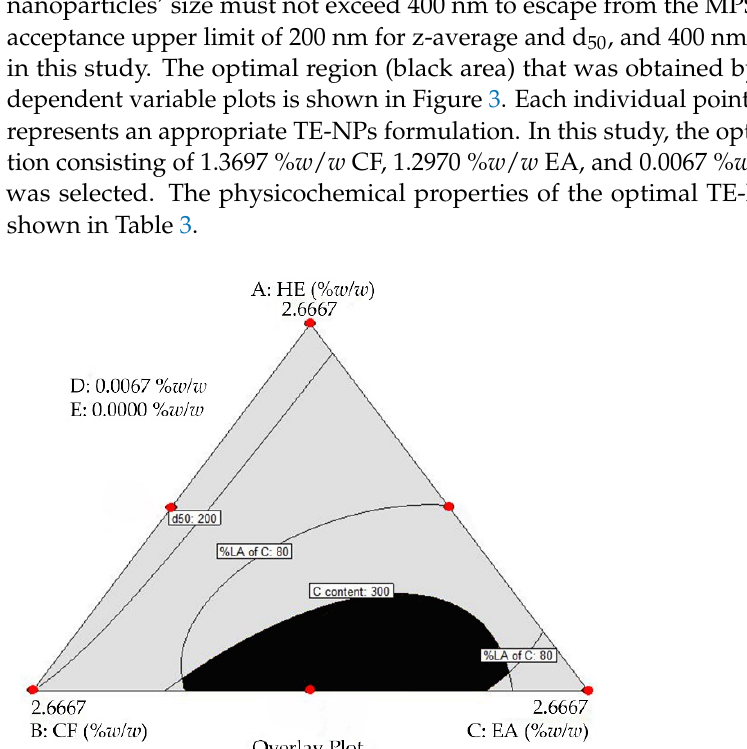
Table 3. Physicochemical properties of the optimal turmeric rhizome extract nanoparticles stored at 5 °C for 3 months (Mean ± SD, n = 3).